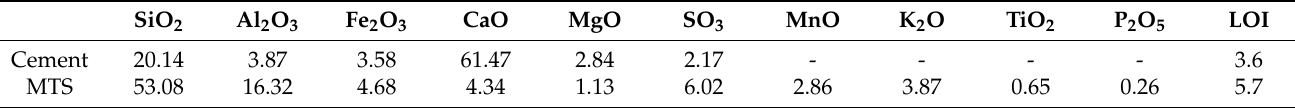
Table 2. Chemical compositions of cement and MTS.